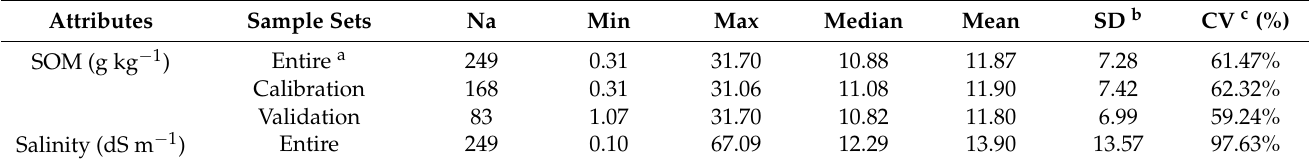
Table 3. Statistical descriptions of SOM and other soil properties.